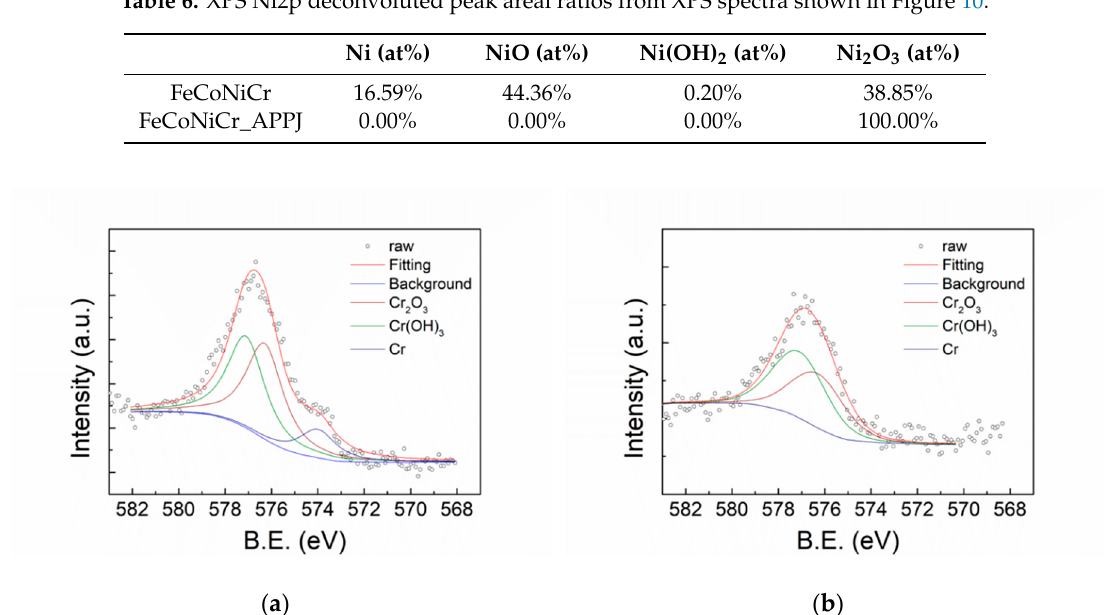
Figure 11. XPS Cr2p spectra of ( a ) FeCoNiCr and ( b ) APPJ-treated FeCoNiCr MEAs.